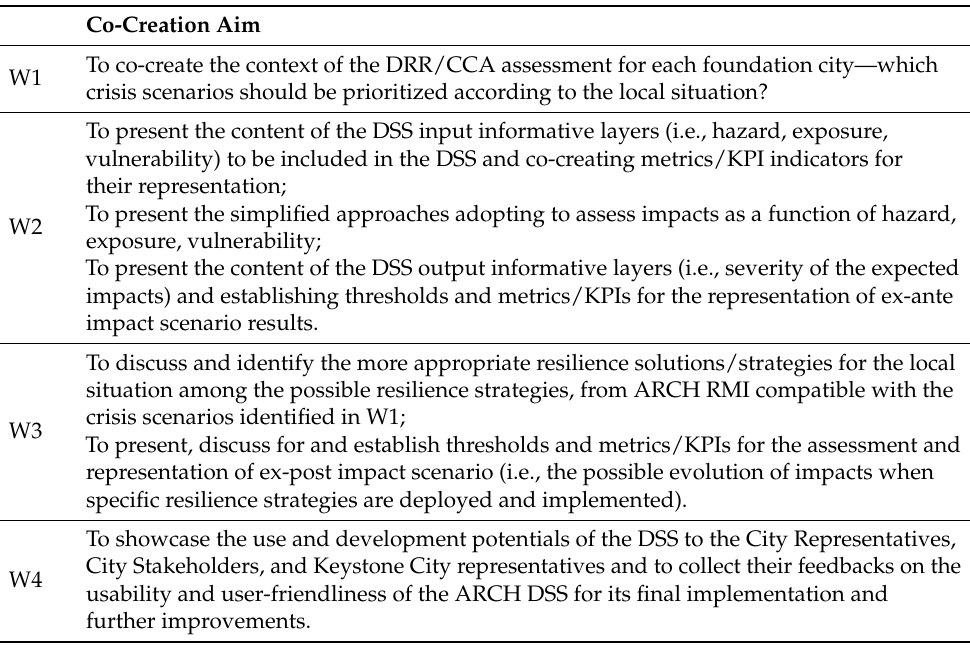
Table 2. Structure of the ARCH DSS co-creation process.